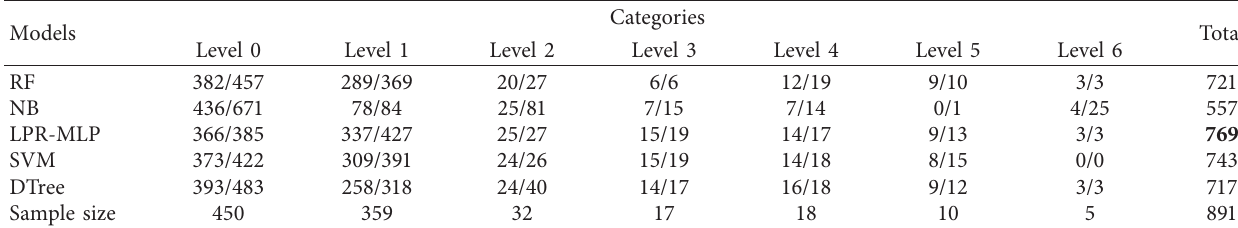
Figure 4: Prediction accuracy of experimental models. Table 3: Summary of the prediction of each model.